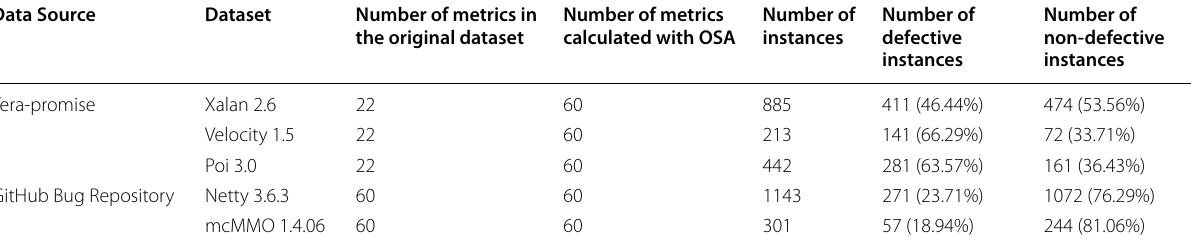
Table 1 Properties of the selected datasets Data